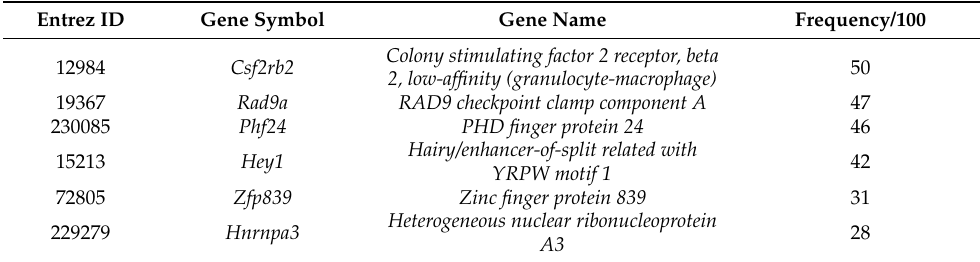
Table 5. The most frequent genes within 100 runs of the iterative feature selection procedure on the dataset without correlated